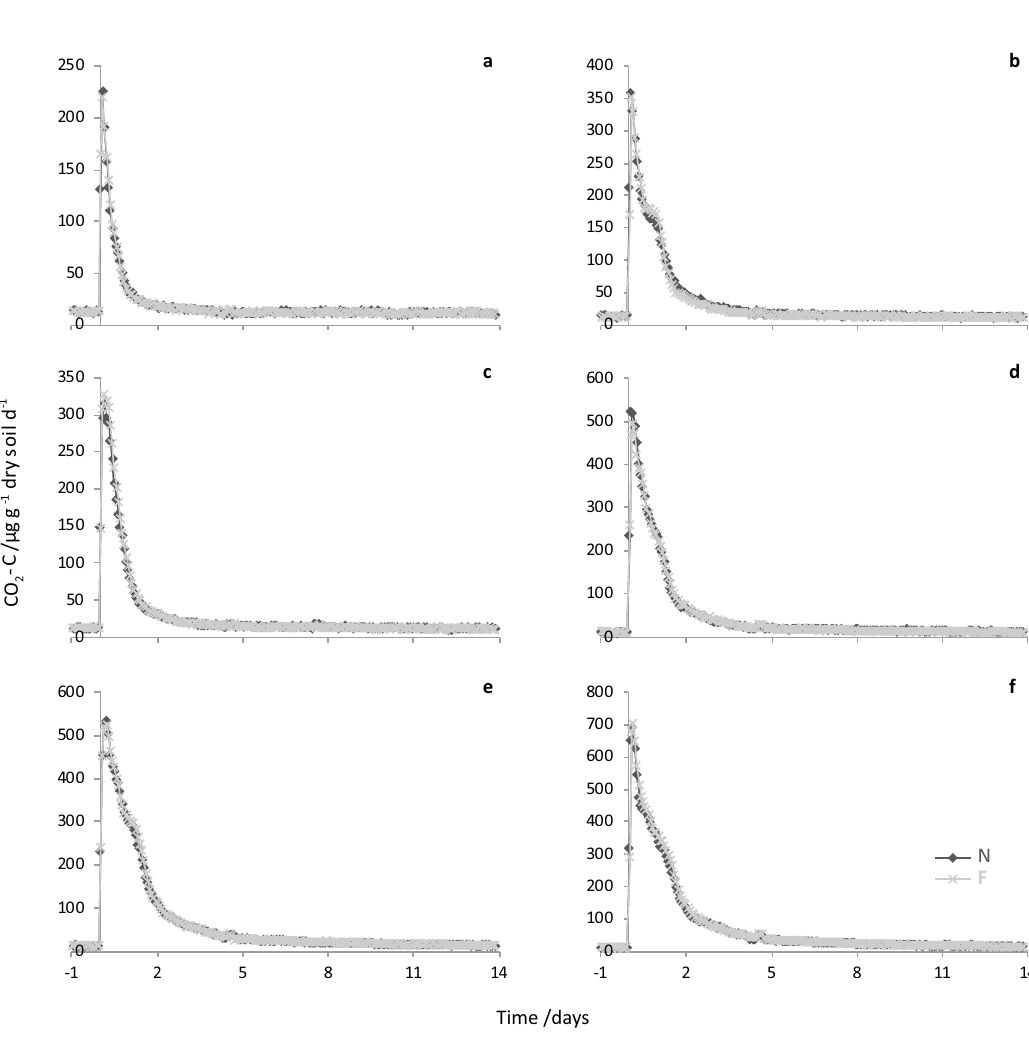
Figure 4. Graphs of paired CO 2 -C fluxes (ug g −1 dry soil d −1 ) from soil amended with non-freeze-dried (N; dark grey diamonds) or freeze-dried and rehydrated (F; light grey crosses) sheep urine samples in FD-1: ( a ) Sample ID 1, ( b ) 2, ( c ) 3, ( d ) 4, ( e ) 5, ( f )